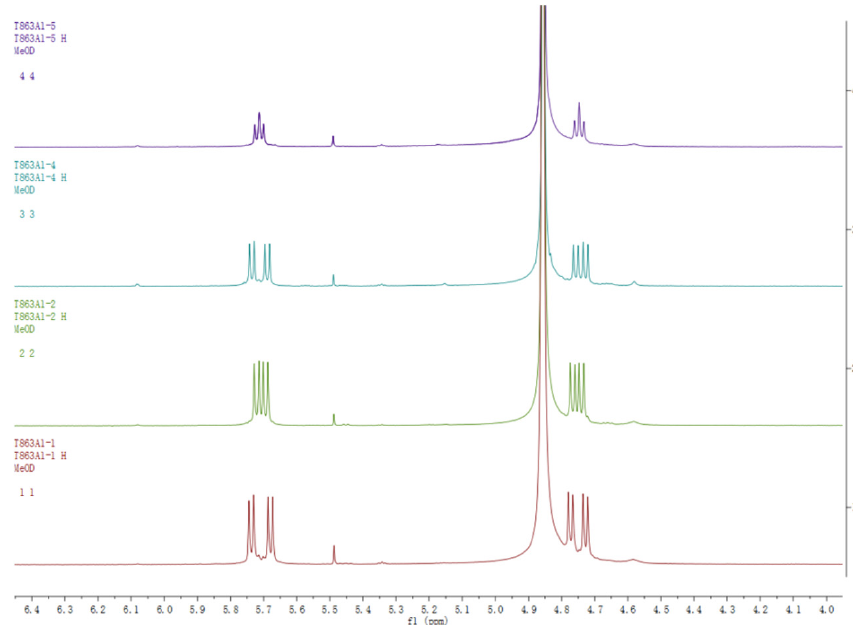
Figure 4. 1 H-NMR comparison of compounds 1 , 2 , 3 , and 4 .